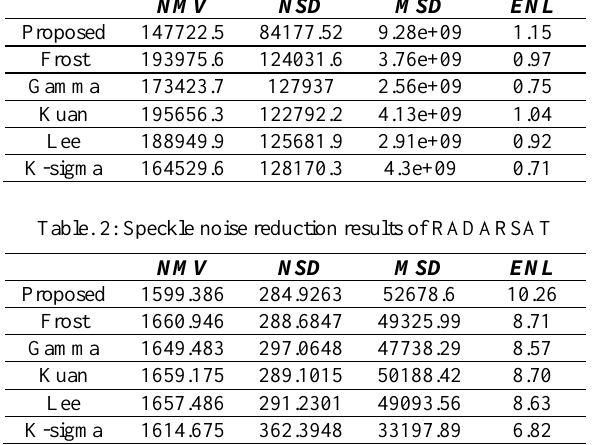
(Figure. 2(a)-(h)) and (Figure. 3(a)-(h)) show a subset of RADARSAT and ENVISAT images and their denoised images,